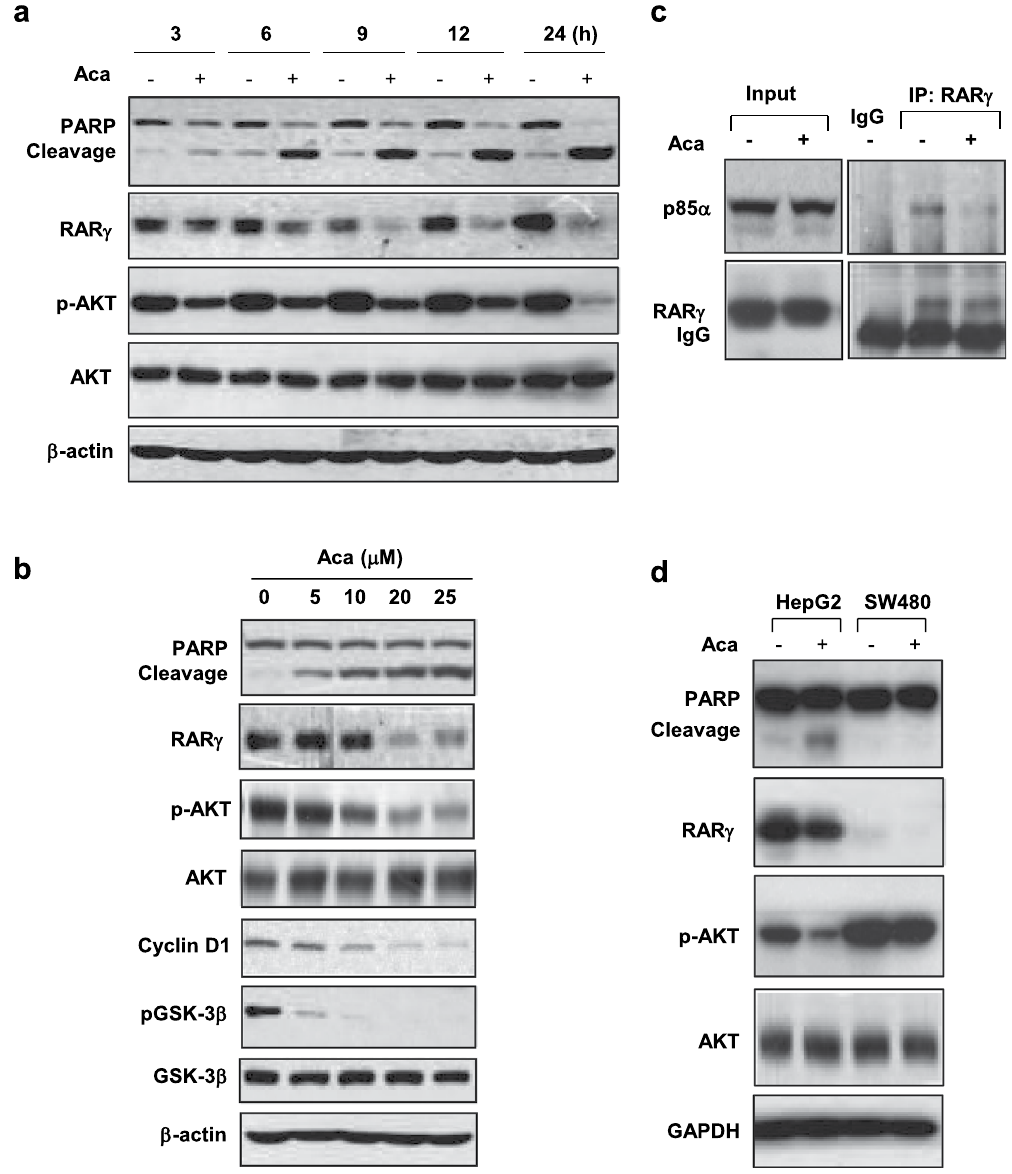
Figure 4. Acacetin induces RAR γ -mediated inactivation of AKT. ( a ) and ( b ) HepG2 cells were treated with 15 μ M acacetin for different time intervals ( a ), or with different concentrations of acacetin for 24 h ( b ). The levels of total and phosphorylated AKT proteins, together with several downstream proteins were analyzed by immunoblotting. RAR γ protein and PARP cleavage were also indicated. ( c ) HepG2 cells were treated with 15 μ M acacetin or vehicle for 12 h. The lysates were incubated with anti-RAR γ antibody and blotted with anti- RAR γ and anti-p85 α antibodies. Rabbit IgG was served as Co-IP control. ( d ) HepG2 and SW480 cells were treated with 15 μ M acacetin for 24 h. The effects of acacetin on AKT phosphorylation were compared between these two cell lines. All blots were cropped to remove irrelevant or empty